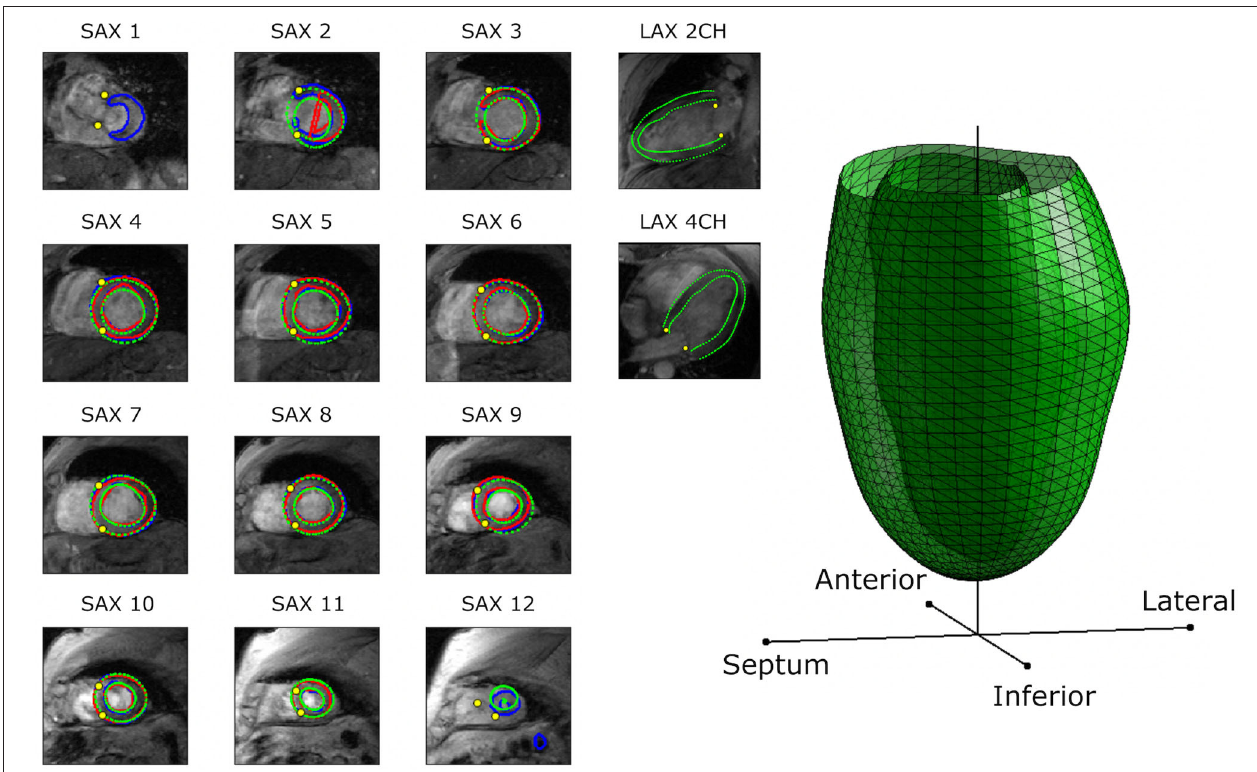
FIGURE 7 | An example of fully automated CMR pipeline result as a patient-specific LV model. Intermediate predictions of the myocardial contours (in blue) and landmark points (yellow circles) are shown in each corresponding DICOM image. Manual contours are shown in red. The intersection contours between the 3D LV model with the images are shown in green. This particular example demonstrates how failed segmentation contours (in apex and base slices) do not affect the final LV model, which are clearly shown in the LAX intersection